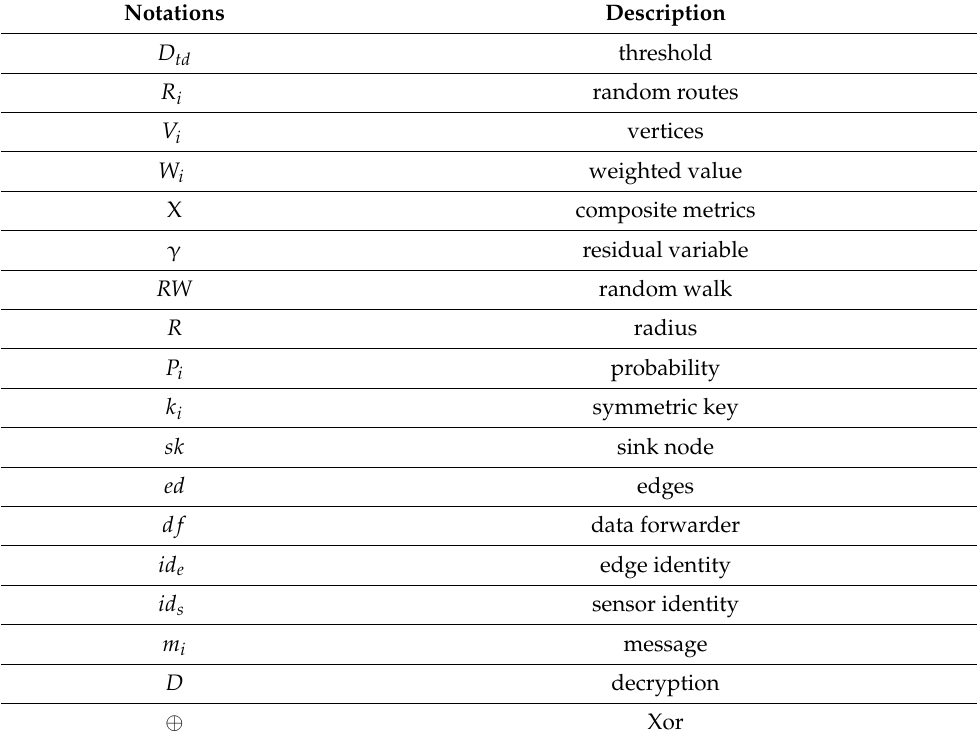
Figure 2. Proposed secured edge algorithm with the support of OTP. Table 2. Notations of the proposed